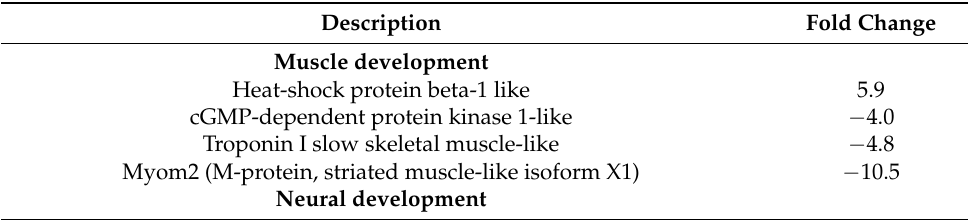
Table 5. Genes associated with morphogenesis that are differentially expressed in non-viable larvae in comparison with viable larvae in European eel Anguilla anguilla . Both groups represent larvae samples taken 1 dph, after which non-viable larvae survived less than 3 dph while viable larvae survived for at least a week up to 22